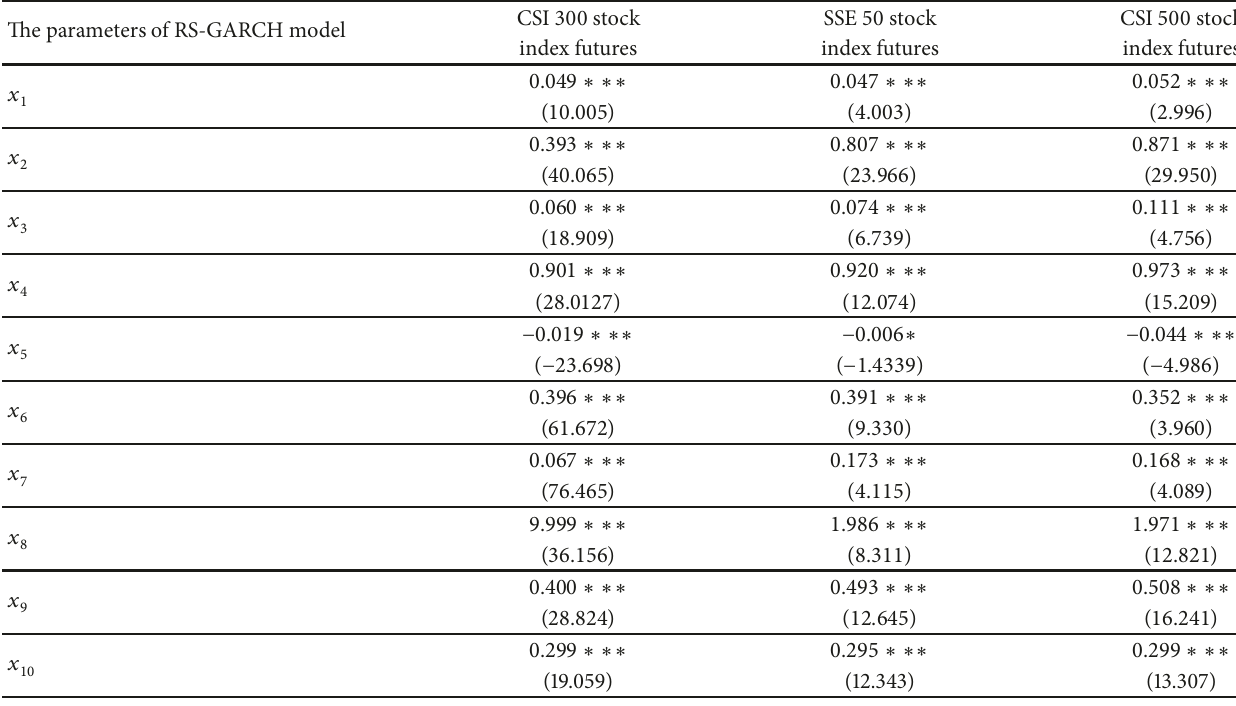
Table 6: The estimation of parameters of RS-GARCH model.